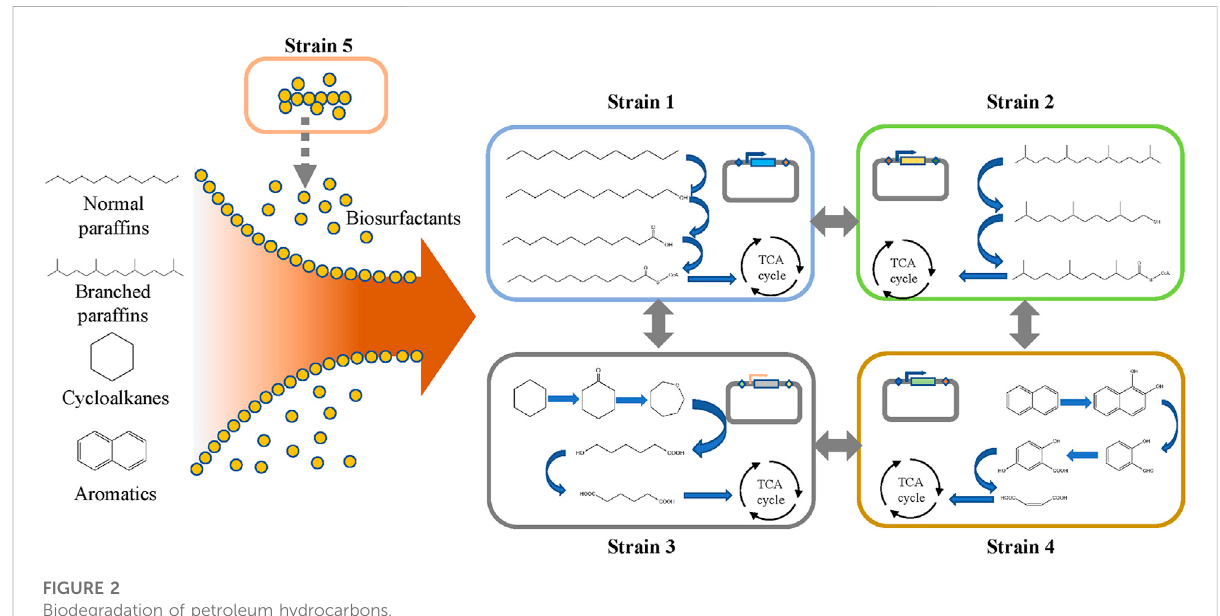
FIGURE 2 Biodegradation of petroleum